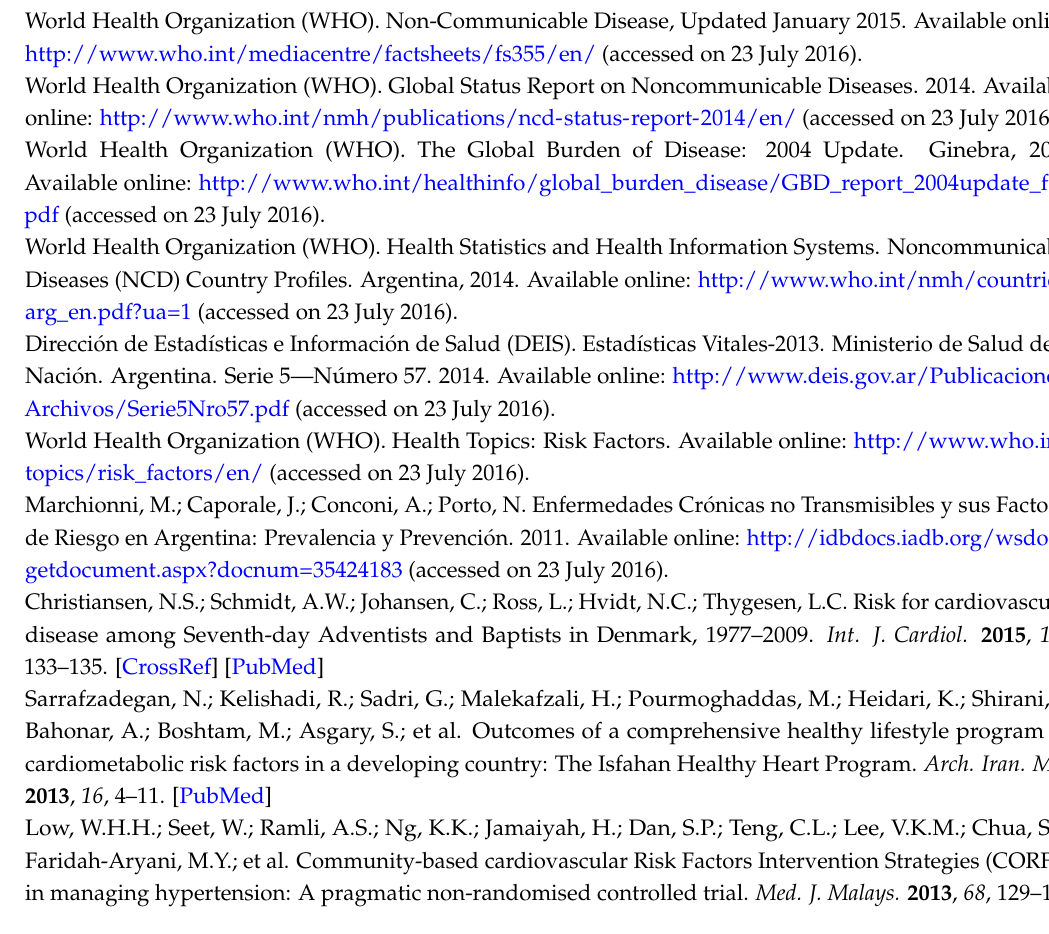
Figure S1: A schematic representation of the geographical localization of Diamante city, Figure S2: The project map of the city of Diamante with the 24 studied zones delimited, and the distributions of participants with their individual code number throughout different areas of the city, Table S1: Website access